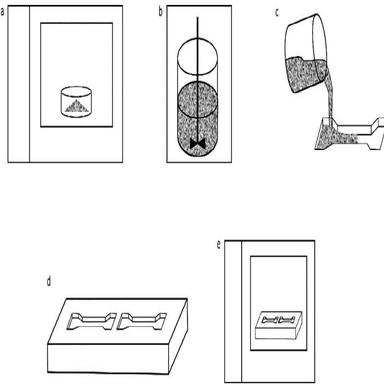
ayer by layer casting process (a) material selection and pre-treatment of reinforcements to reduce moisture content ; b) reinforcements and matrix material blending; c) Transferring into mould layer by layer d) layup until the desired composition and thickness obtained; e) curing in the oven.